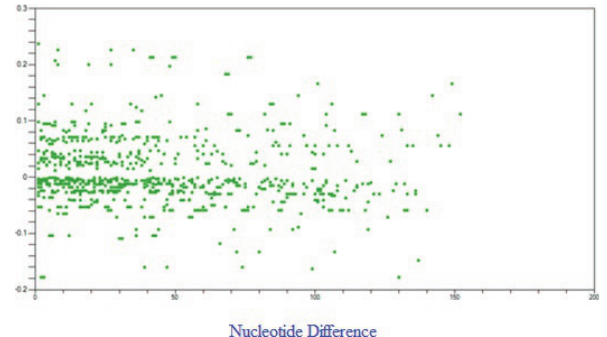
Figure 4. trnHG-psbA nucleotide difference among Avicennia spe-